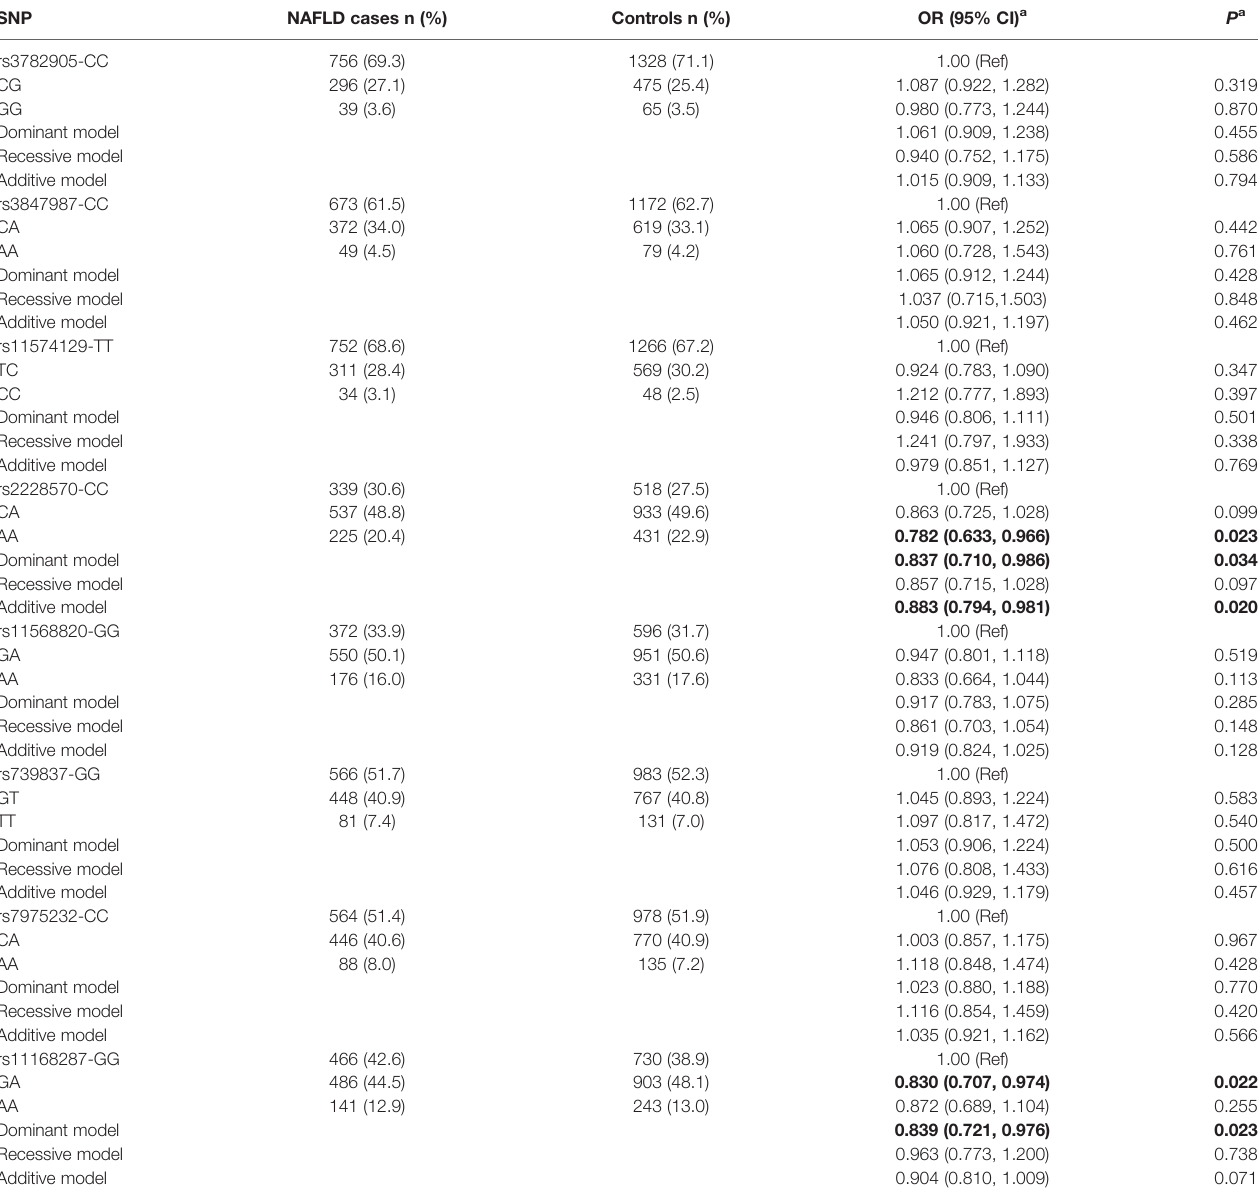
TABLE 3 | Genotype distributions of VDR polymorphisms among the two study groups and association analyses of these eight SNPs and NAFLD. SNP NAFLD cases n (%) Controls n